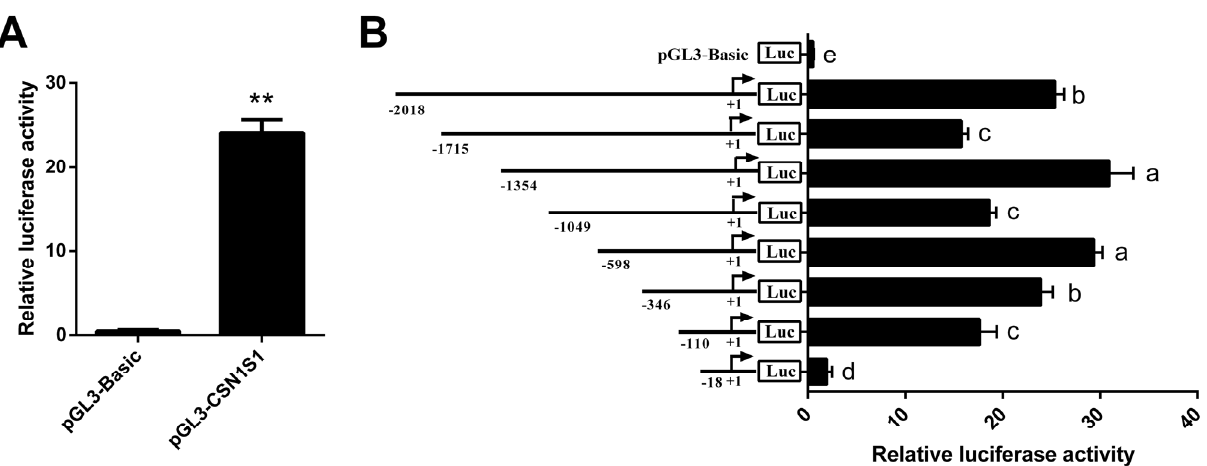
Figure 2. Deletion analysis of the goat CSN1S1 promoter. ( A ) Relative luciferase activity of full-length CSN1S1 promoter. ( B ) Relative luciferase activity of the CSN1S1 promoter in different lengths. Serial CSN1S1 promoter deletions ( − 2018/+183, − 1715/+183, − 1354/+183, − 1049/+183, − 598/+183, − 346/+183, − 110/+183, − 18/+183 bp) were transfected into GMEC and incubated at 48 h for luciferase assays. Data are shown as means ± SEM for 3 biological replicates. ** p < 0.01. Differences between 2 groups are considered significant at lowercase letters, p < 0.05.